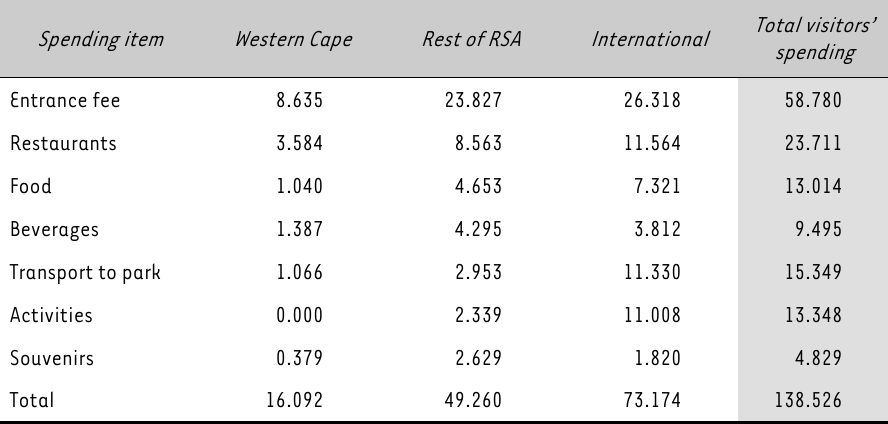
Total spending of visitors according to origin (in ZAR millions, 2006 prices) Spending item Western Cape Rest of RSA Entrance